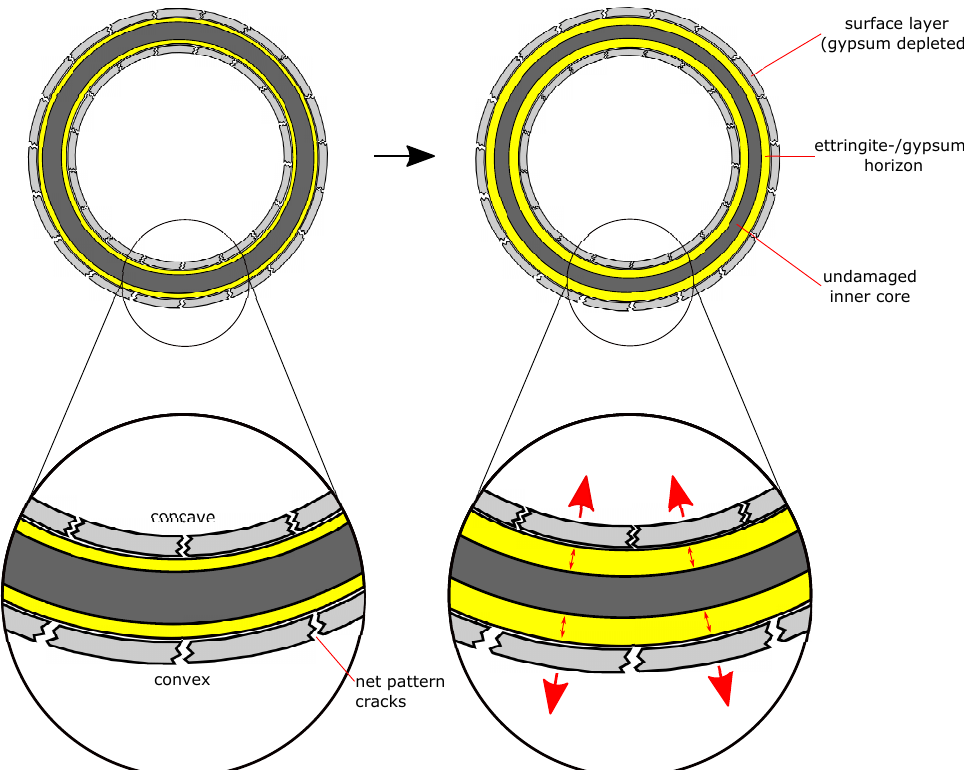
Figure 11. Schematic representation (not to scale) of the cross-section of a hollow cylinder that experiences an ongoing expansive formation of ettringite and/or gypsum beneath the surfaces due to the ingress of sulphate ions. The concave inner surface has a higher degree of restraint compared to the convex outer